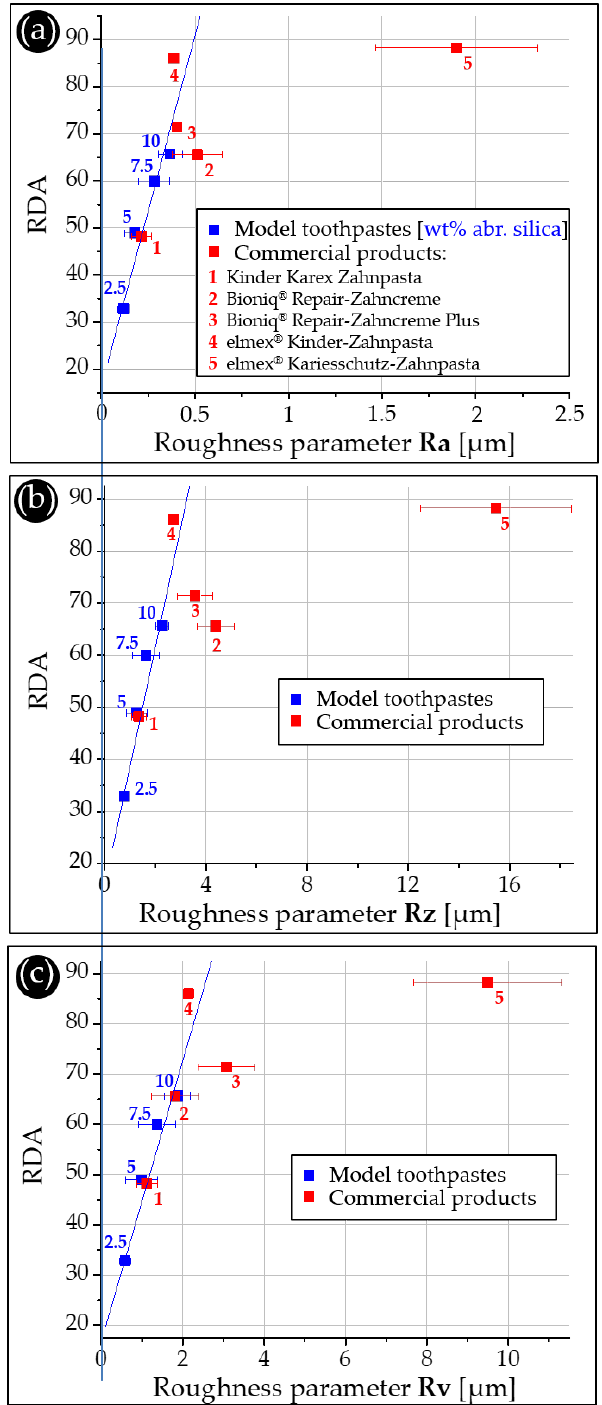
Figure 7. Correlation between the roughness parameters and the associated RDA values. ( a ) Ra values, ( b ) Rz values and ( c ) Rv values of the model toothpastes (blue) and the tested commercial products (red) plotted against their experimentally determined RDA values.